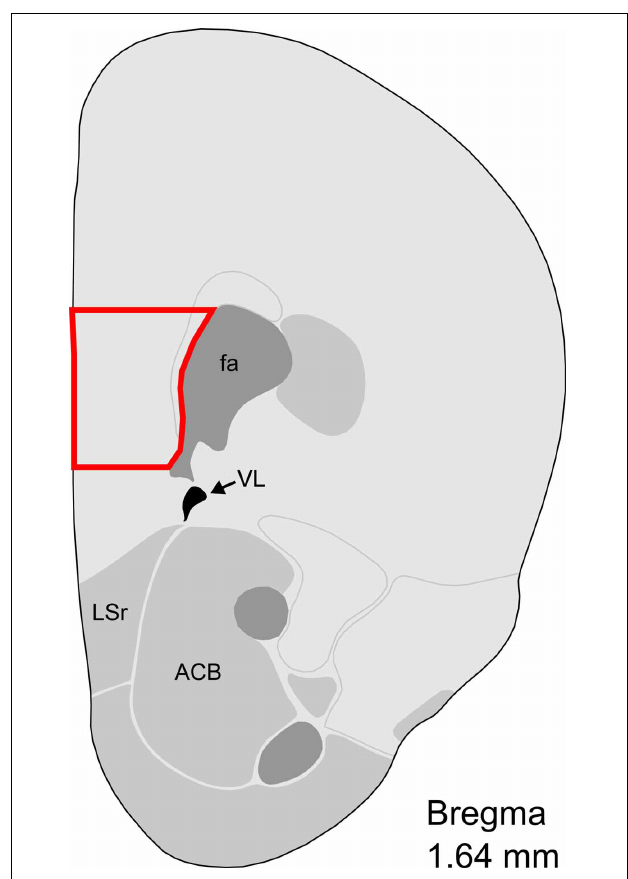
FIGURE 1 | Representative section with mPFC dissection for microarray analysis. Distance from Bregma in the rostrocaudal plane is indicated. Modified from the Allen Mouse Brain Atlas (reference atlas version 1, 2008). Abbreviations: fa, corpus callosum, anterior forceps; VL, lateral ventricle; LSr, lateral septum, rostral; ACB, nucleus